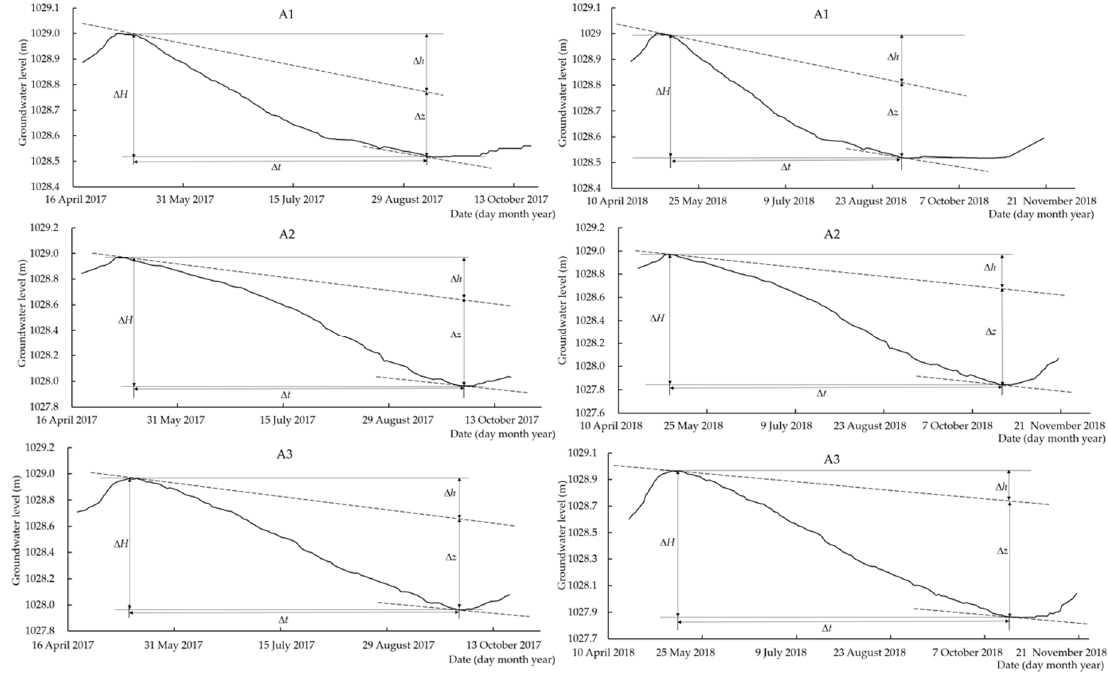
Figure 7. Determination of groundwater Δ h and Δ z in the growth period.